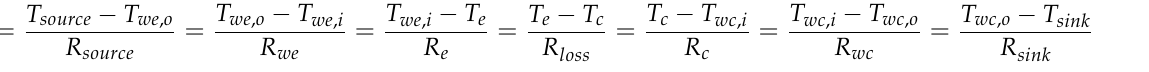
shown in Equation